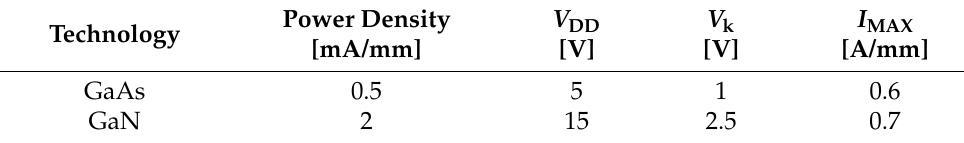
Table 3. Technology parameters.